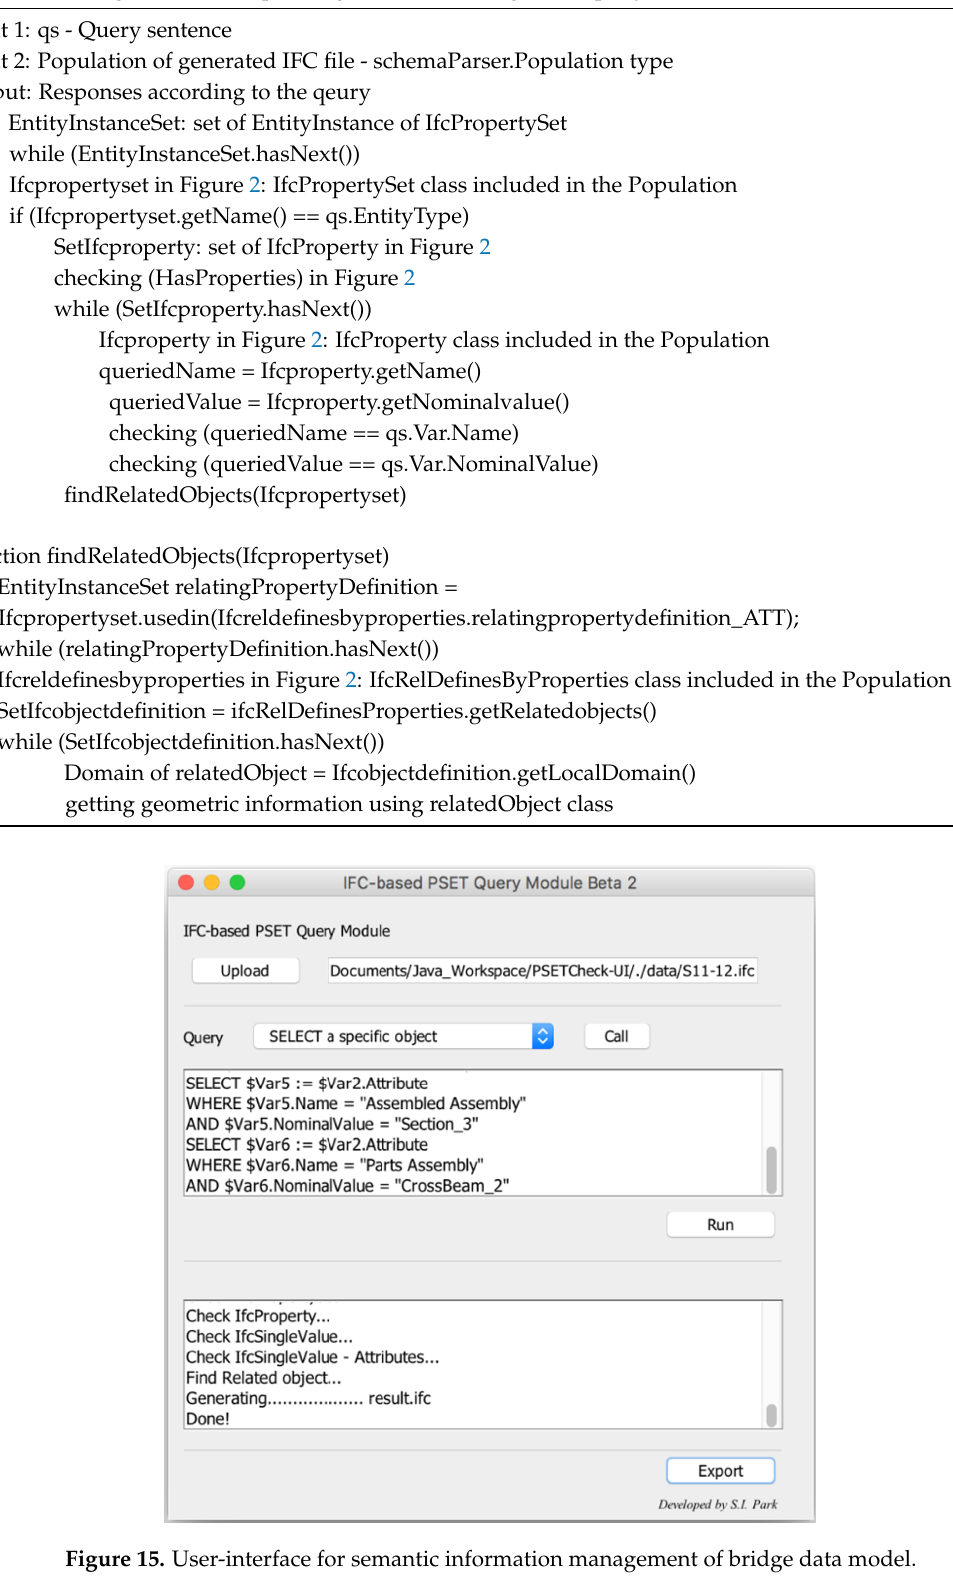
Algorithm 2. Algorithm for responding results according to the query sentence.